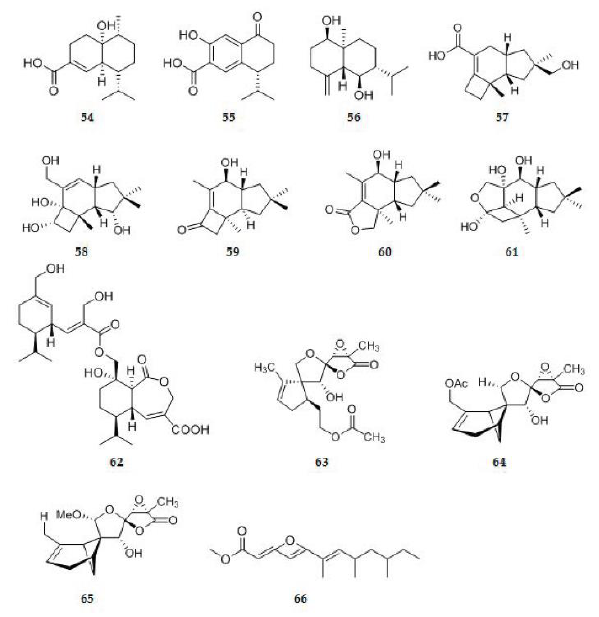
Figure 2. Chemical structures of sesquiterpenoids and derivatives.